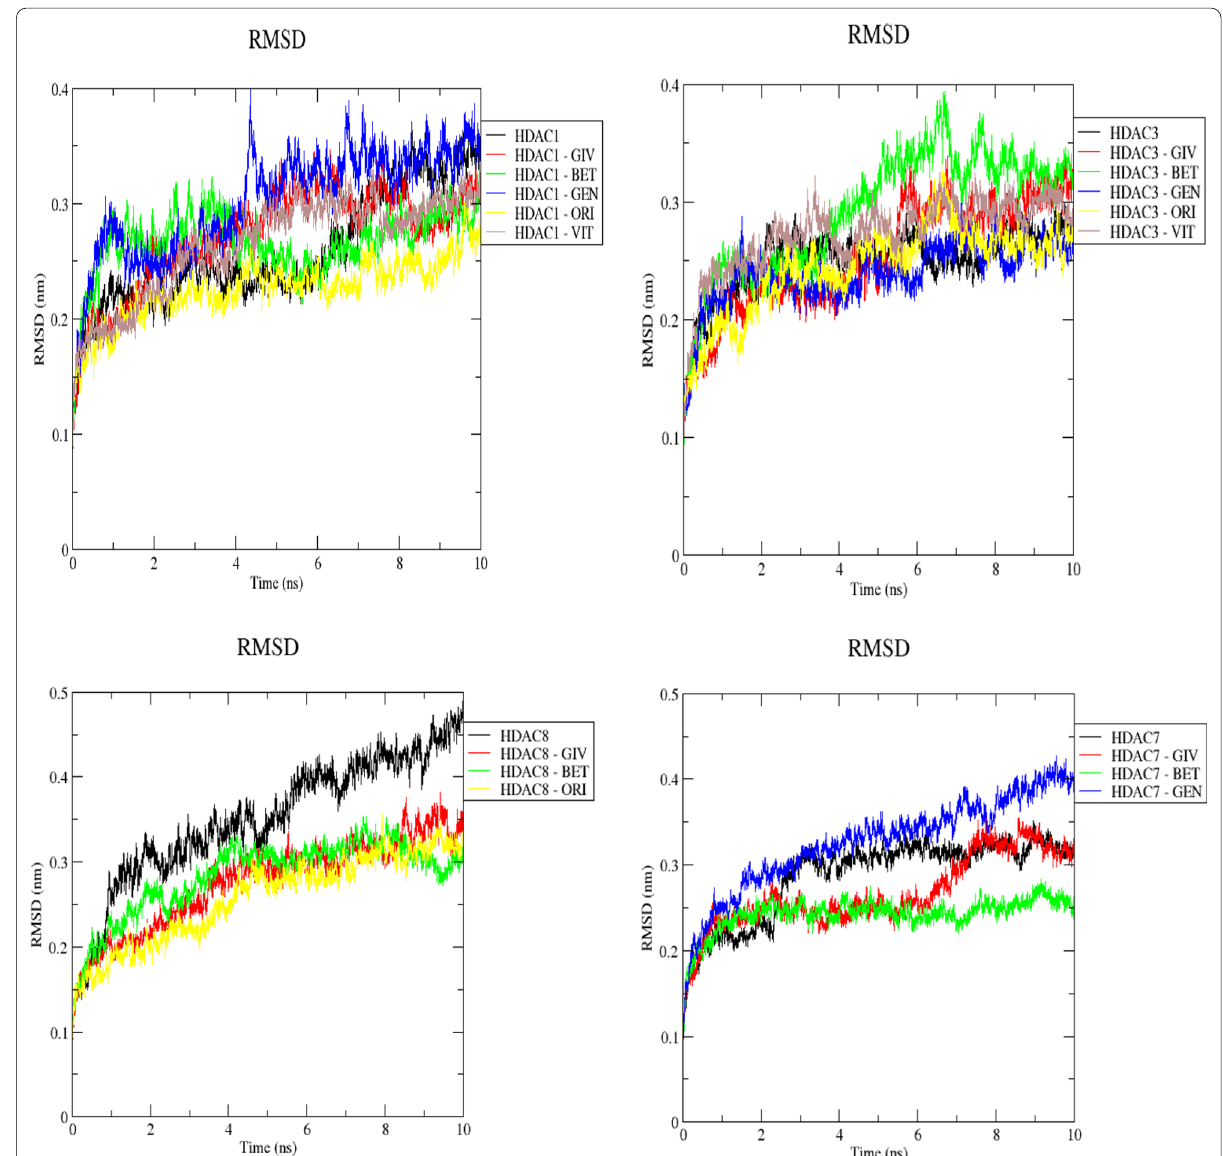
Fig. 9 RMSD study plot of HDAC1, HDAC3, HDAC8 and HDAC7 complexes during 10 ns of MD